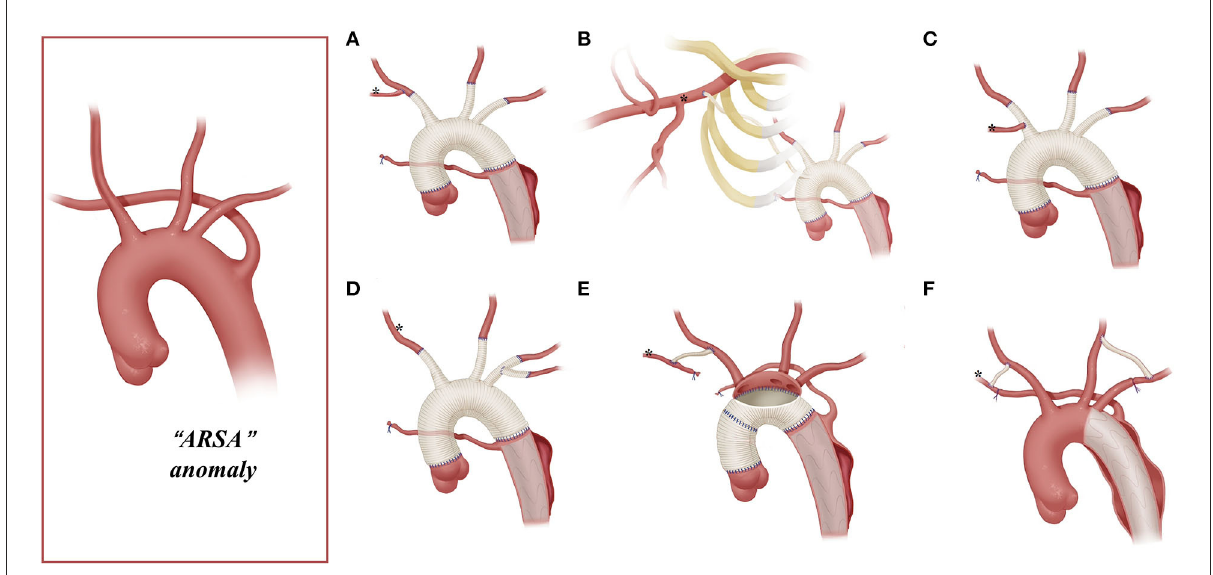
FIGURE2 Arch technique for ARSA in patients with type A aortic dissection. *Distal ARSA; (A) stage TAR for ARSA; (B) extra-anatomy revascularization of the right axillary artery; (C) ARSA connected to the vascular graft of the RCCA; (D) ARSA directly anastomosed to the 8-mm arch branch of the four-branched graft; (E) en bloc technique for the ARSA; (F) hybrid technique for ARSA.